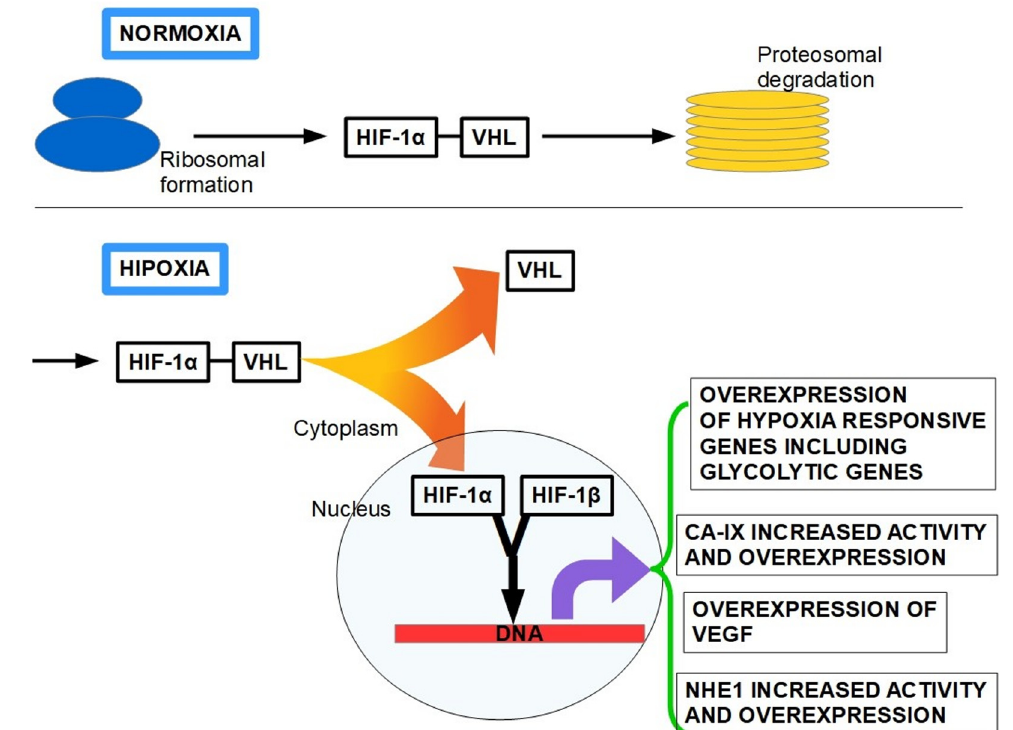
Figure 5. The “fate” of the HIF-1 α protein with the oxygen tissue level. Upper panel : HIF-1 α is unstable in normoxia because due its binding to the VHL protein, it is carried to proteasomal degradation. Lower panel : The situation changes under hypoxic conditions. When HIF-1 α is released from VHL (stabilization) and translocates to the nucleus, it dimerizes with the constitutional HIF-1 β . This dimer acts as a transcription factor for a set of genes that contain a Hypoxia Responsive Element (HRE) sequence in their promoter region. On the right side there are some of the genes that are promoted by the dimer.